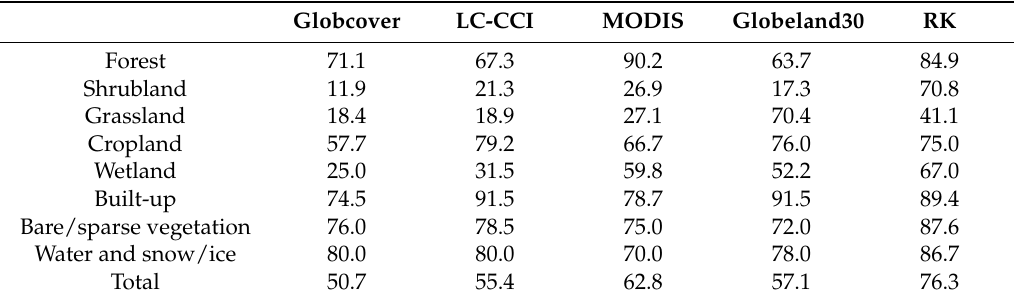
Table 3. Class-specific correspondences of RK integration and the input GLC maps with reference data.